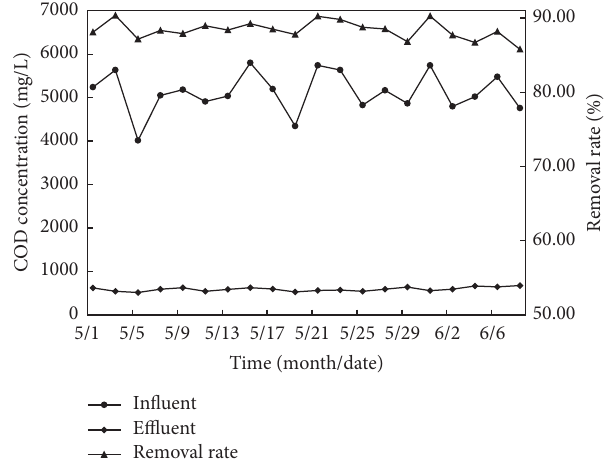
Figure 3: COD removal from the